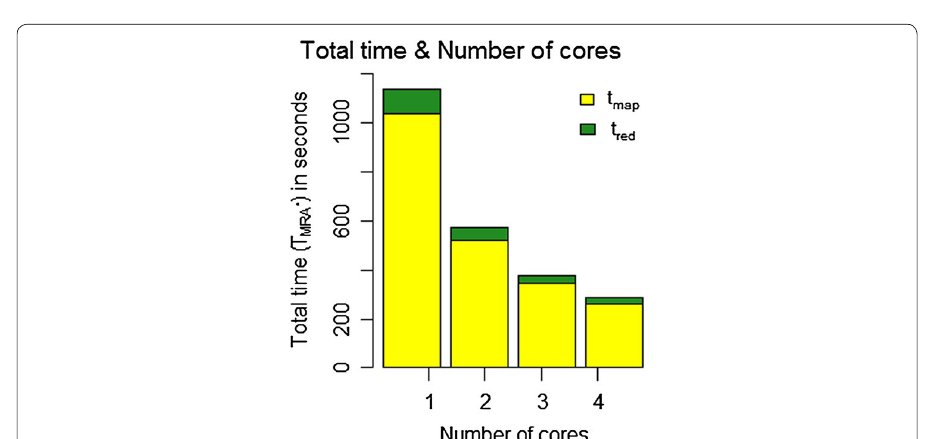
Fig. 11 Impact of number of core processors on the computational time (with graph of 60,000